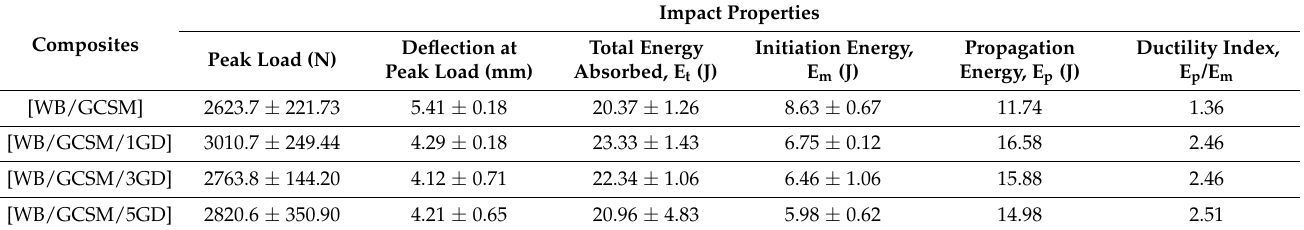
Table 3. Impact properties of [WB/GCSM], [WB/GCSM/1GD], [WB/GCSM/3GD] and [WB/GCSM/5GD] composites.